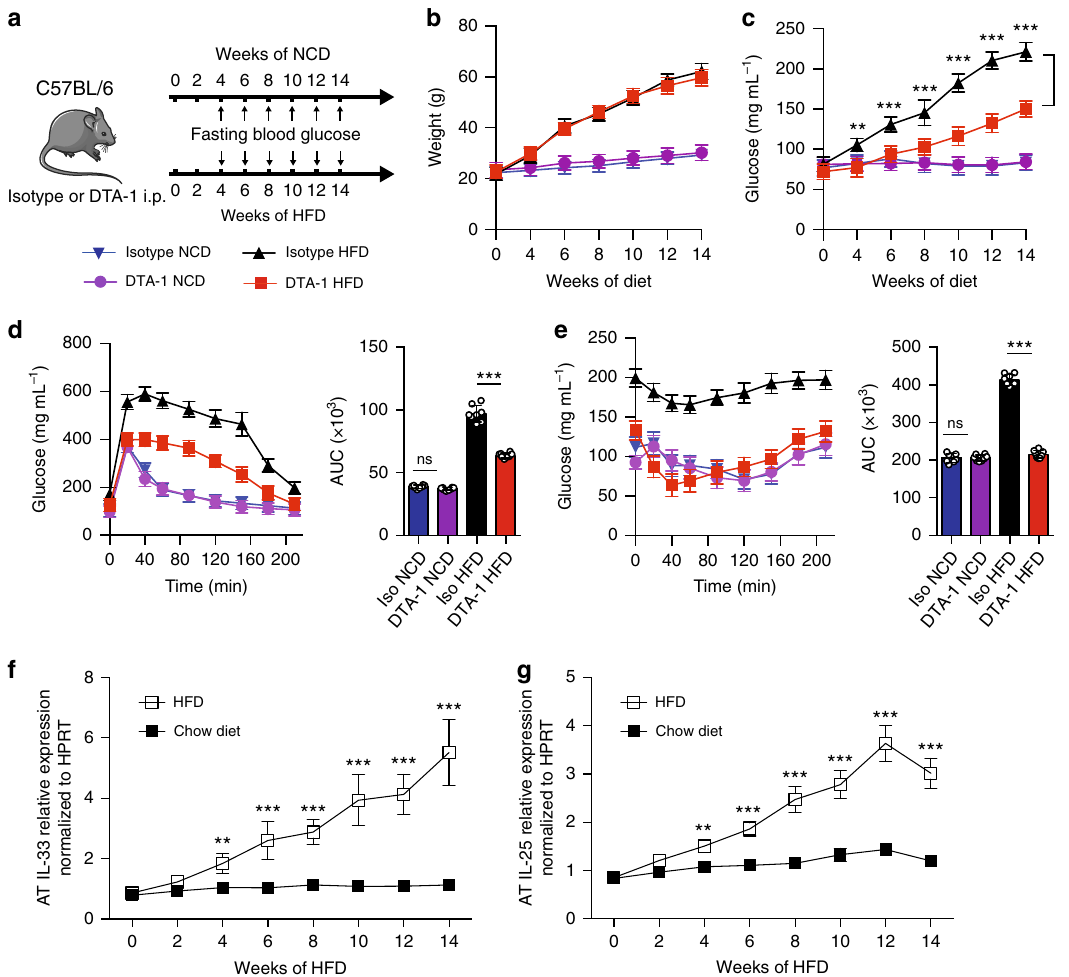
Fig. 2 Engagement of GITR protects from the onset of Type 2 Diabetes. a A cohort of C57/BL6 mice fed a normal chow diet (NCD) or a high fat diet (HFD) were either treated with DTA-1 (1 mg/mouse) or isotype control by intraperitoneal injections every four days according to the scheme, n = 8. b Total weight and c fasting blood glucose levels were measured every two weeks for 14 weeks. Glucose tolerance test ( d ) and insulin tolerance test ( e ) were performed in a cohort of C57BL/6 mice fed a NCD or a HFD and treated for 14 weeks with or without DTA-1. The corresponding area under the curve was calculated for each group. Time-kinetic qPCR expression of IL-33 ( f ) and IL-25 ( g ) on VAT lysates. Error bars are the mean ± SEM. Student ’ s t -test, ** p < 0.01, *** p < 0.001, ns, non-signi fi cant. Mouse image provided with permission from Servier Medical